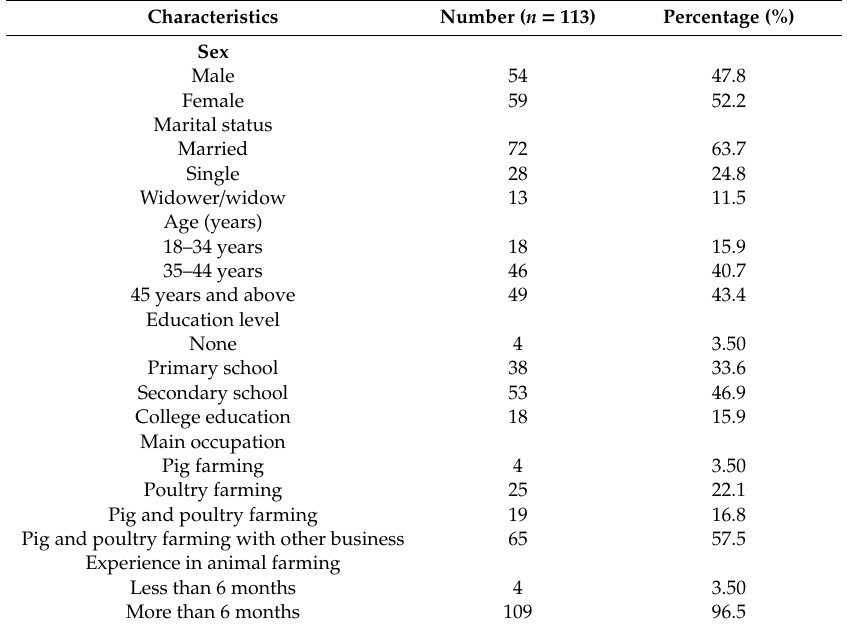
Table 1. Socio-demographic characteristics of participants for questionnaire